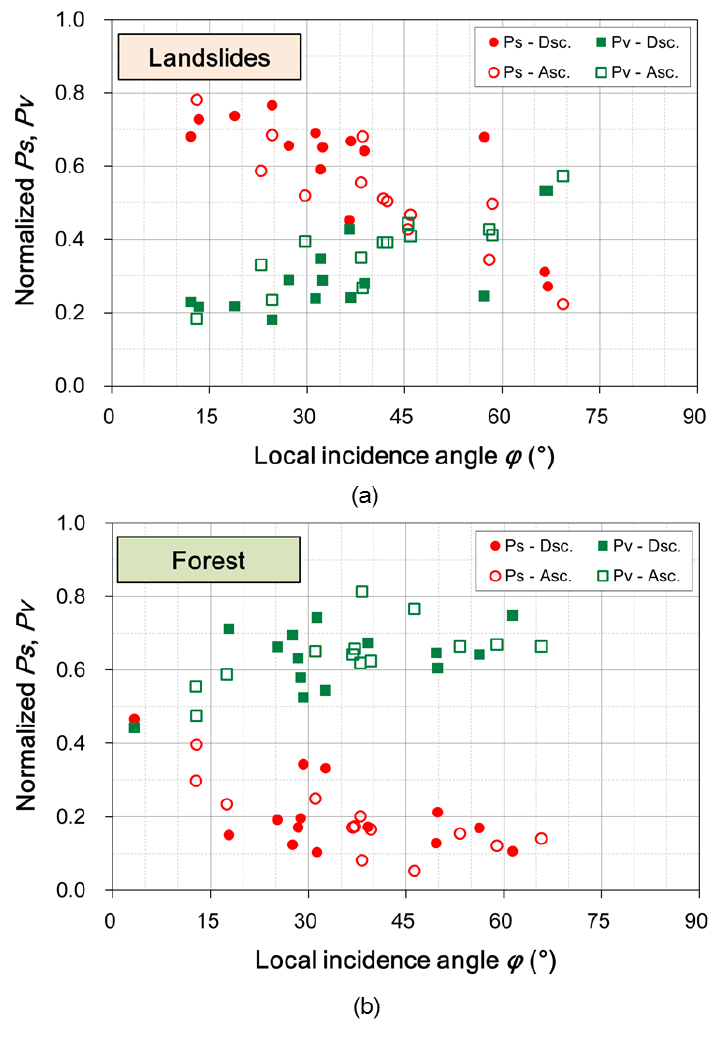
Figure 9. Normalized powers of the surface and the volume scattering components’ ( p s and p v ) contribution to the total power with respect to the local incidence angle in ( a ) landslides and ( b ) forested areas for PALSAR-2 data acquired with ALOS-2 from its descending and ascending